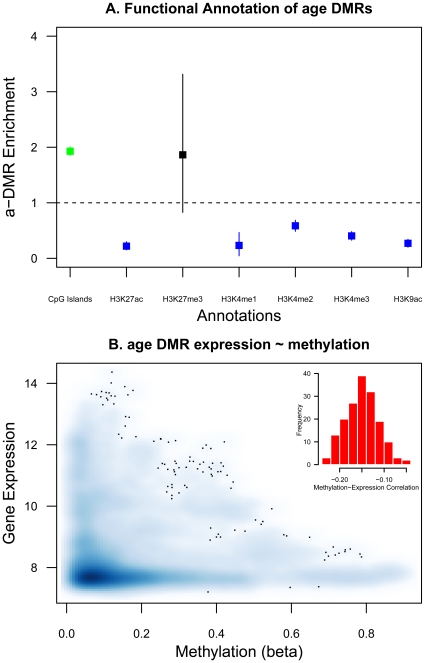
Functional characterization of a-DMRs.A. Enrichment and depletion of a-DMRs in functional genomic categories. Enrichment is calculated as the proportion of a-DMRs in each functional category (CpG islands (green) or HapMap CEPH LCL histone peaks (blue, black)) over the proportion of 26,690 probe in that functional category. Bars represent the 95% bootstrap percentile confidence intervals. B. Whole blood methylation and LCL gene expression estimates in the age DMR genes show significant negative correlation (histogram shows the distribution of gene-based rank correlation coefficients between methylation and gene expression).